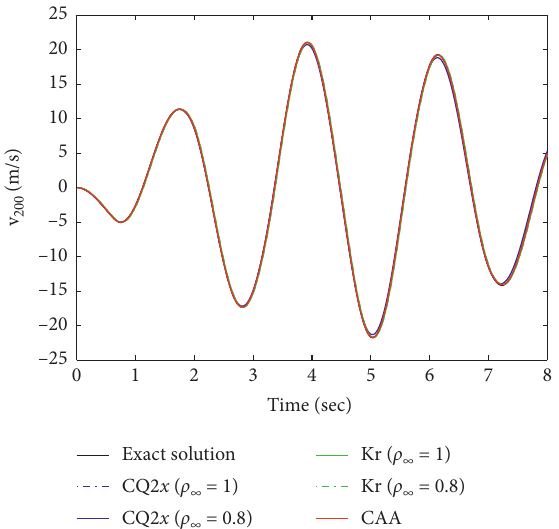
Figure 34: Velocity responses of the 200th DOF when n � 200.